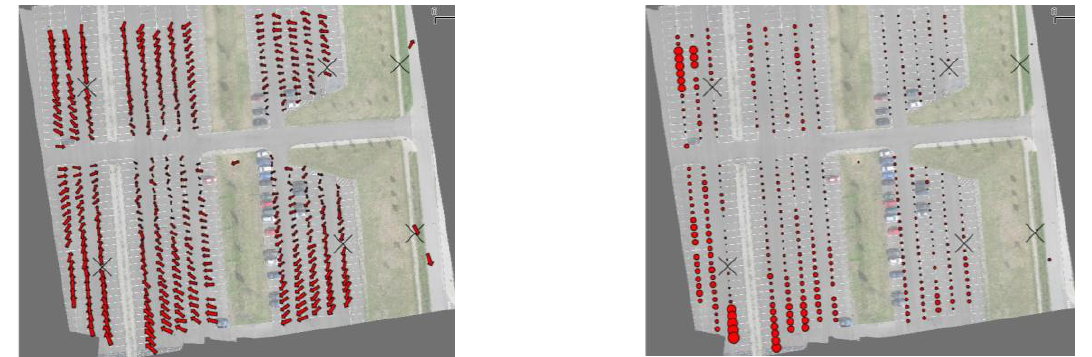
Figure 4. Positional (left) and height deviations (right) of the point cloud derived with